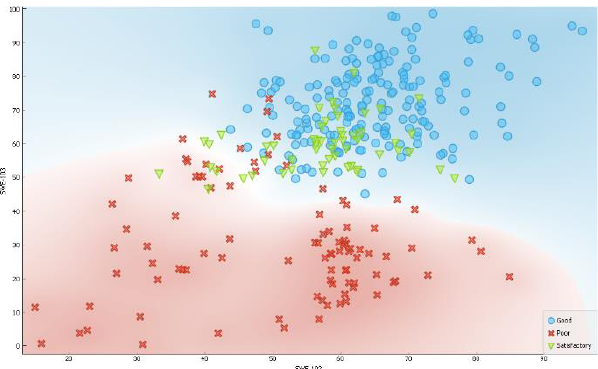
Fig. 1. Scatter plot demonstrating the relationship between SWE-102 and SWE-103 of Cohort 1